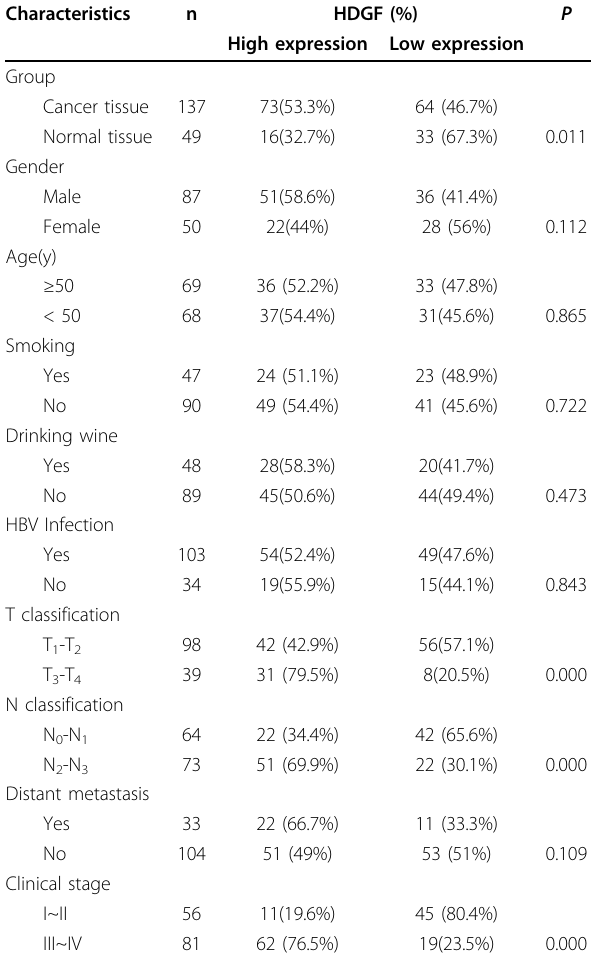
Table 1 Correlation between the clinicopathologic characteristics and expression of HDGF protein in liver cancer